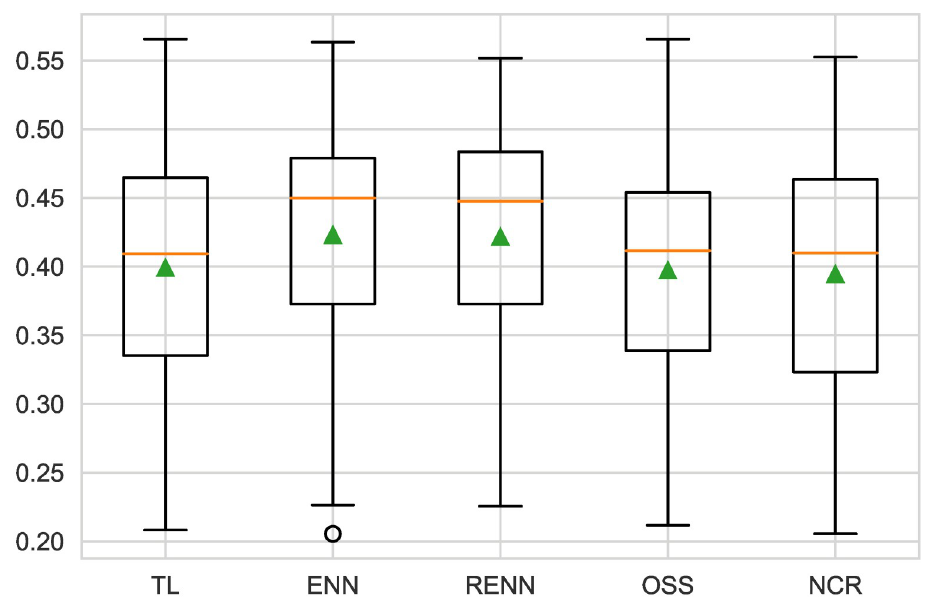
Fig 9. Boxplot of undersampling for NB. The ENN score was the highest (0.423), the RENN score was slightly lower (0.079), and the other three undersampling scores were similar.